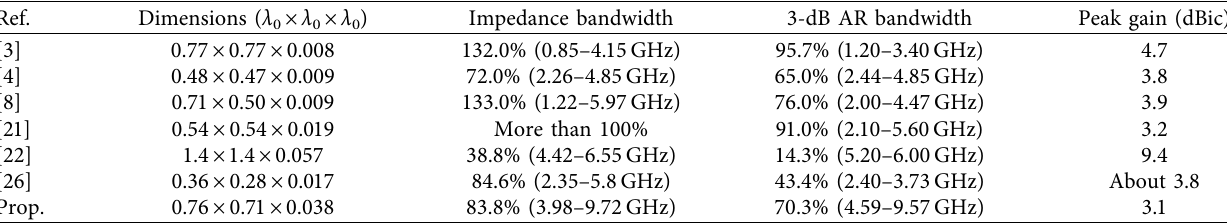
Figure 11: Simulated and measured radiation patterns at (a) 5.5 GHz, (b) 7.5GHz, and (c) 9.5GHz. Table 1: Comparisons of the proposed and other CP